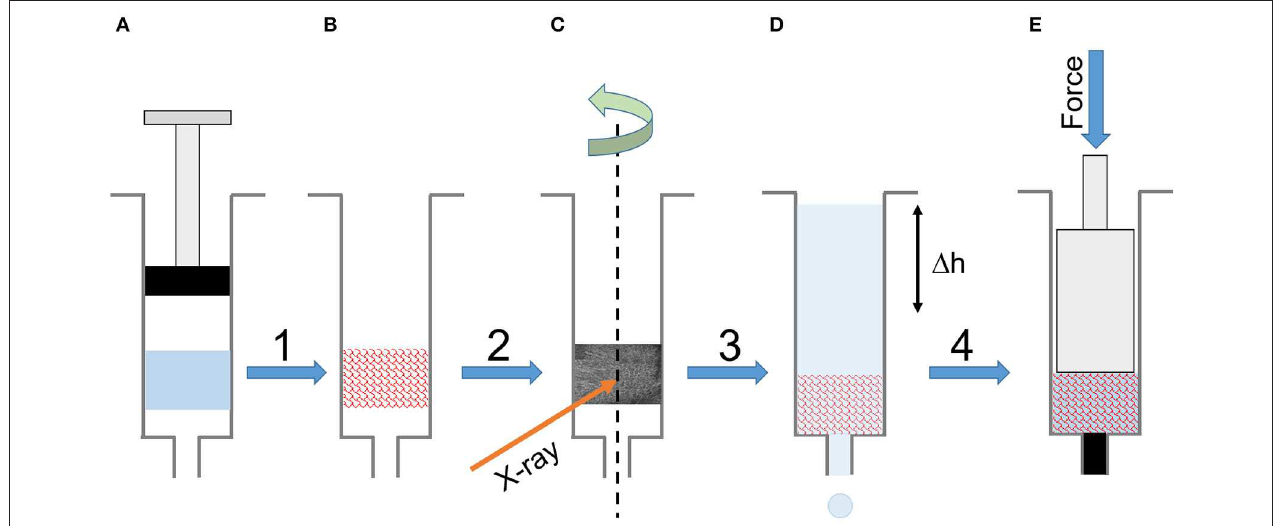
FIGURE 1 | Experimental workflow. (A) The silk solution gelled in a 1mL syringe. (B) The final scaffold after freezing and freeze-drying. (C) Tomography of the dry scaffold in the syringe. (D) Permeability measurement in the syringe using a timed water column elution. (D) The mechanical compression of the wet scaffold in the